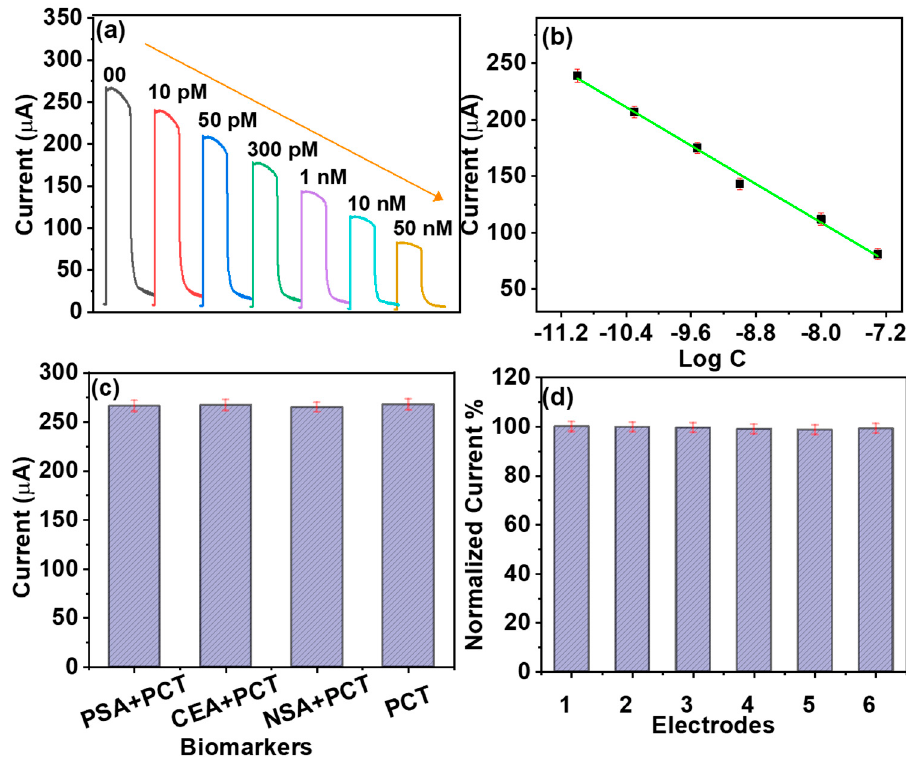
Figure 6. ( a ) Photo-current responses of Ab 1 / CuWO 4 @rGO / GCE against the di ff erent concentration of Figure 6. (a) Photo-current responses of Ab 1 /CuWO 4 @rGO/GCE against the different concentration of PCT in the range of 50 ng · mL − 1 to 10 pg · mL − 1 ; ( b ) the corresponding inhibition calibration plot; ( c ) PCT in the range of 50 ng·mL − 1 to 10 pg·mL − 1 ; ( b ) the corresponding inhibition calibration plot; ( c ) the